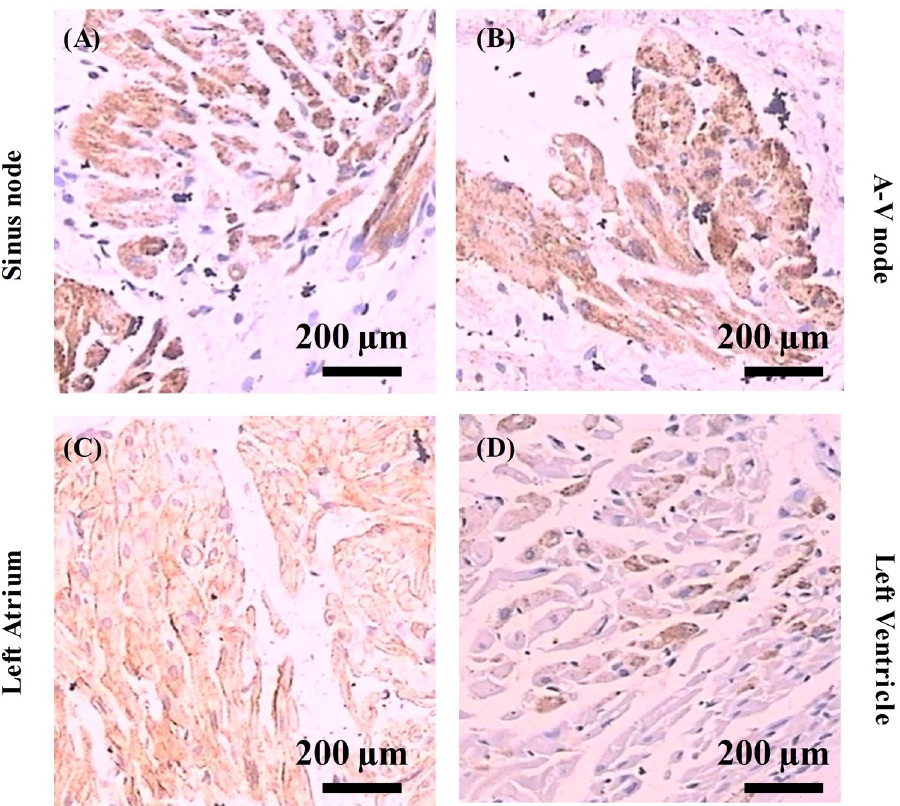
Figure 1. Distribution of Ecrg4 in adult rat heart by immunohistochemistry. Specimens of Sinus node, A-V node, left atrium, and left ventricle were dissected from adult SD rat hearts, and processed for IHC as described. Representative images showing that Ecrg4 (brown staining) is expressed in Sinus node ( A ), A-V node ( B ), left atrium ( C ), and sporadically in ventricular myocytes of left ventricle ( D ). Scale bar, 200 µ m.